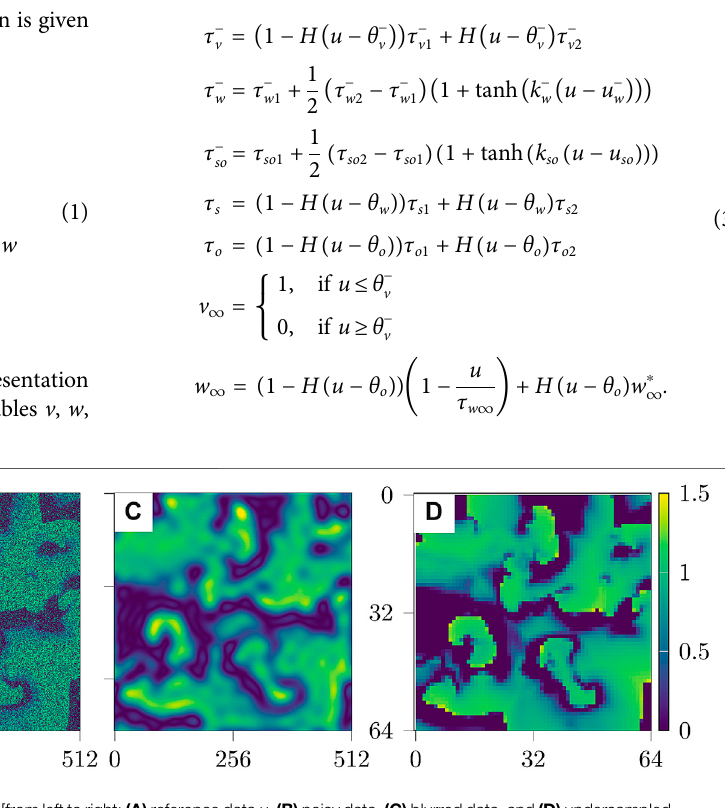
FIGURE2| Snapshotsofthethreecasesofimpaireddatabasedon u [fromlefttoright: (A) referencedata u , (B) noisydata, (C) blurreddata,and (D) undersampled data].